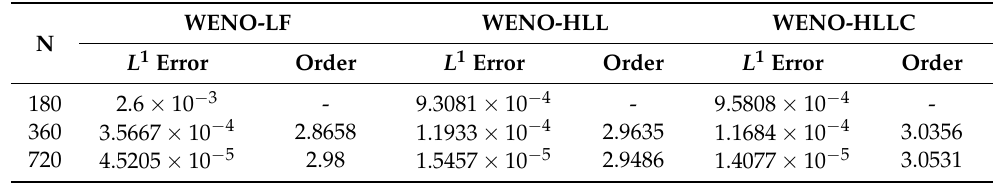
Table 1. L 1 errors and numerical orders of accuracy with WENO–LF, WENO–HLL, and WENO– HLLC fluxes at t =